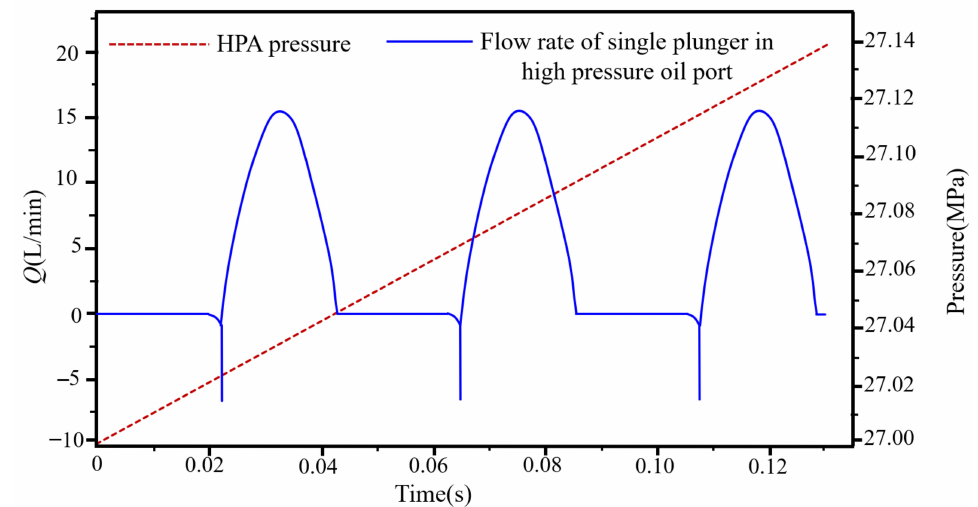
Figure 5. Diagram of high pressure accumulator (HPA) pressure and single plunger flow rate at high pressure oil port on pump